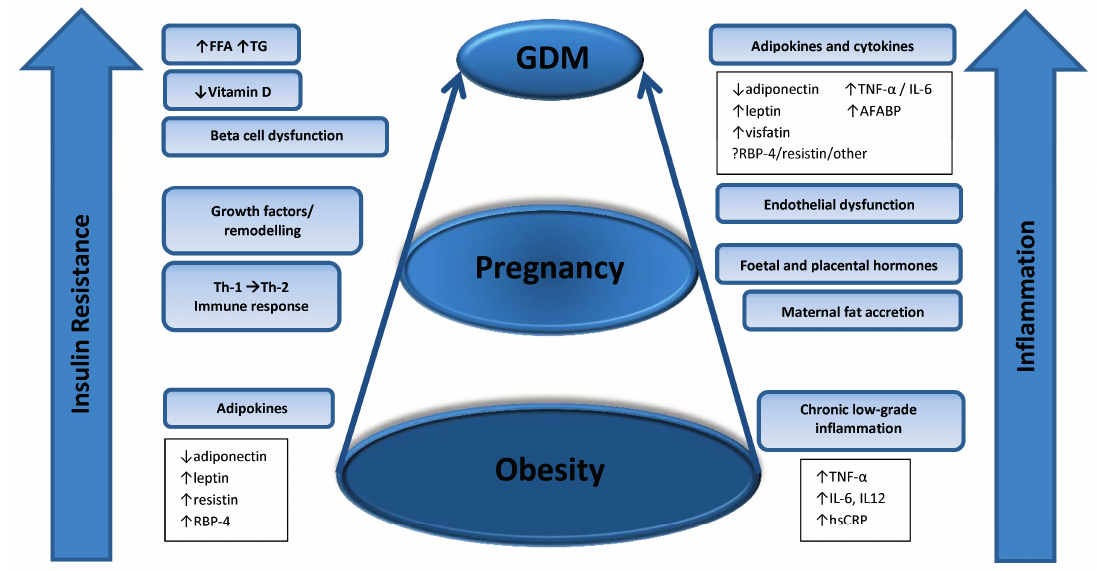
Figure 2. A proposed model of inflammation and insulin resistance in obesity, pregnancy and GDM. Women who are obese have features of chronic low-grade inflammation, manifest by increased tumour necrosis factor alpha (TNF- α ), interleukin-6 (IL-6), interleukin-12 (IL-12), and high sensitivity C-reactive protein (hsCRP). Obesity is characterised by insulin resistance, and down-regulation of adiponectin and up-regulation of leptin, resistin and retinol-binding protein-4 (RBP4) contribute to this. Pregnancies occurring in obese women are characterised by further inflammation and a Th-2 predominant immune response, which may contribute to pregnancy complications. Foetal and placental hormones, production of abnormal growth factors and tissue remodelling may contribute to inflammation and increasing insulin resistance. GDM develops when beta cell dysfunction coexists, and may be characterised by further abnormalities in adipokine and cytokine profiles, increased free fatty acids (FFA), triglycerides (TG), low vitamin D and endothelial